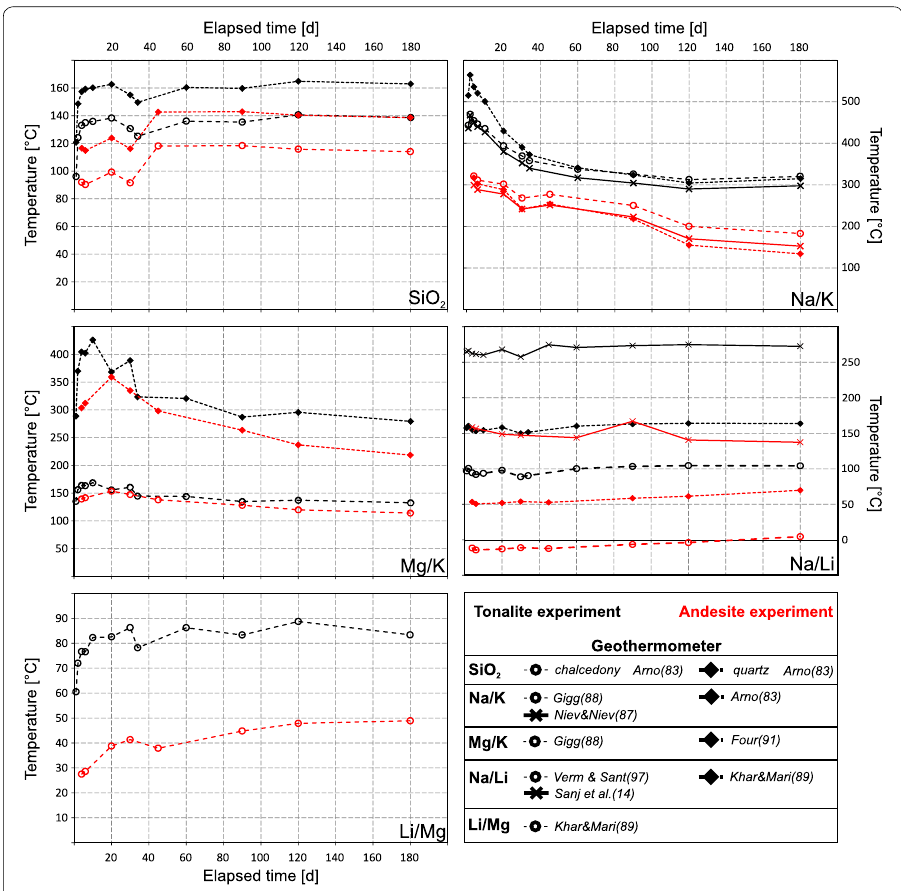
Fig. 2 Calculated solute geothermometer temperatures for the experimental fluids plotted versus elapsed reaction time (tonalite experiments black symbols , andesite experiments red symbols ). Temperatures were calculated from Arnórsson (1983), Fournier (1991), Giggenbach (1988), Kharaka and Mariner (1989), Nieva and Nieva (1987), Sanjuan et al. (2014) and Verma and Santoyo